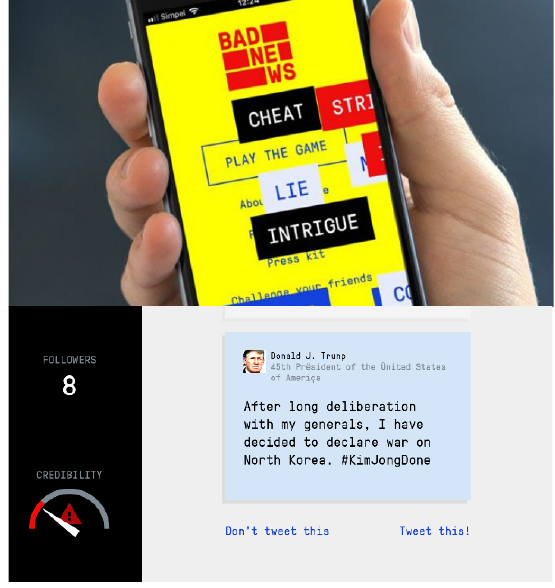
Figure 1. Bad News landing page and